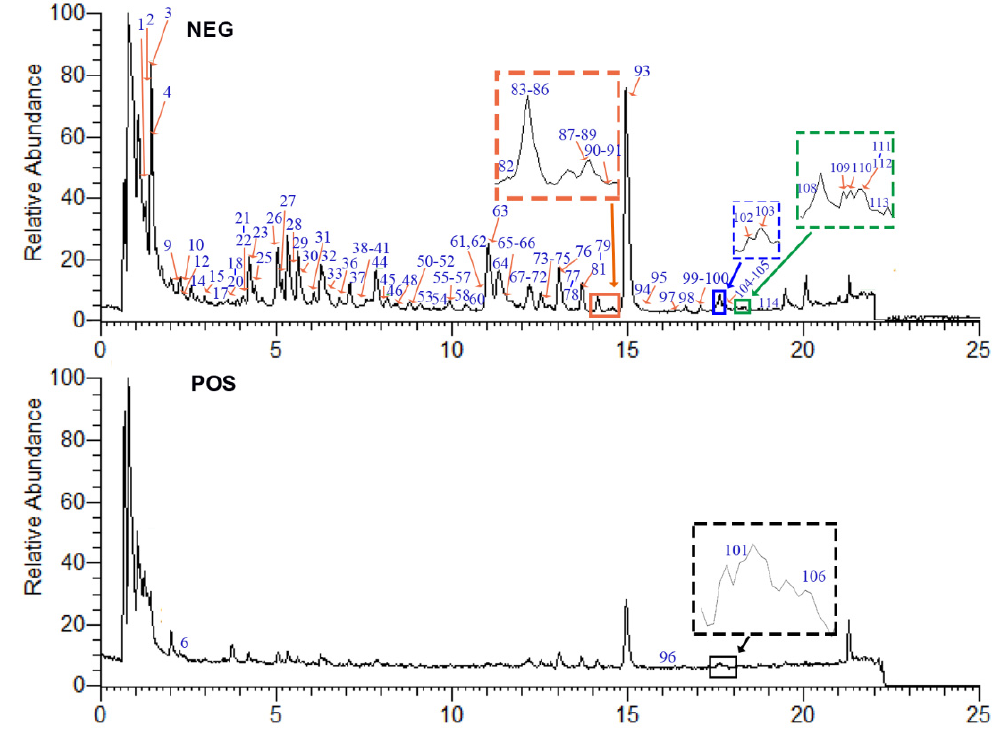
Figure 1. The TIC chromatograms of P. capitatum extract in negative (NEG) and positive (POS) ion